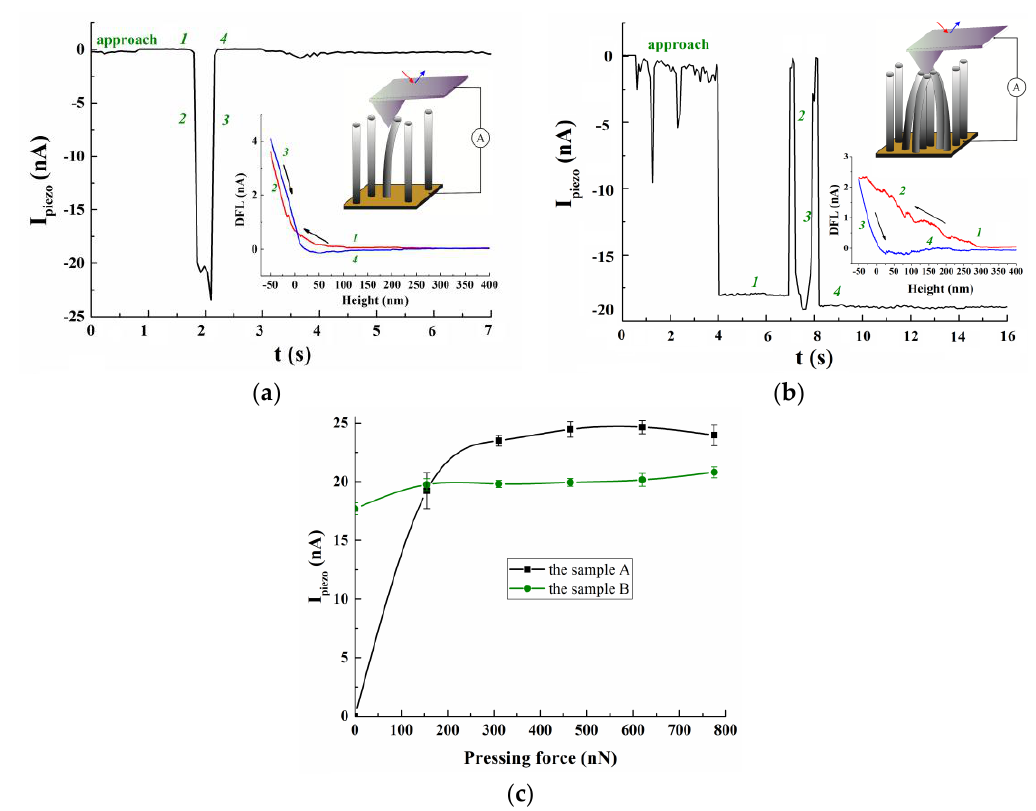
Figure 2. The results of the piezoelectric response study: ( a ) an individual carbon nanotube of sample A; ( b ) a bundle of strained CNTs of sample B. The inserts show schematic images of the measurement process and the results of AFM force spectroscopy: 1—force is not applied to the AFM probe, 2—gradual force is applied to the AFM probe, 3—gradual force decay back to zero, 4—the AFM probe returns to initial state 1; ( c ) the relationship between the detected current and the applied force of the AFM